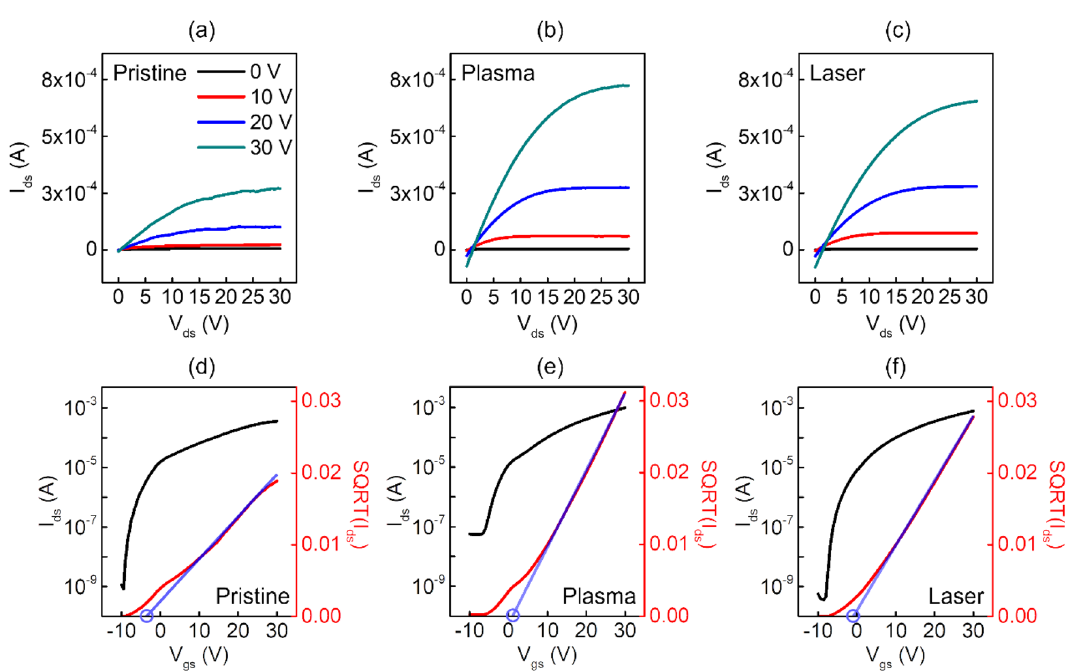
Figure 3. Output characteristics of multi-stacked IZO TFTs with ( a ) pristine, ( b ) plasma, and ( c ) femtosecond laser pre-annealing. Transfer characteristics and SQRT transfer curves of multi-stack IZO TFTs with ( d ) pristine, ( e ) plasma, and ( f ) femtosecond laser